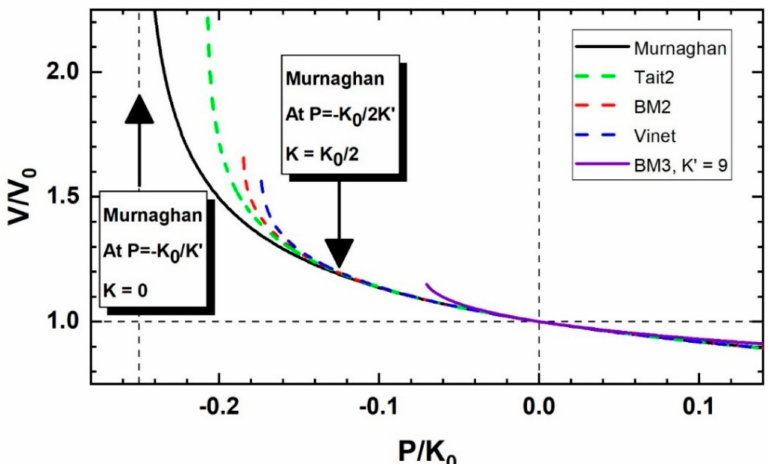
Figure 2. Volume-pressure variation for Murngahan, Vinet, 2nd-order Tait and Birch-Murnaghan isothermal EoS, with K 0 = 125 GPa and K’ 0 = 4, parameters similar to mantle composition olivines and forsterite (e.g., [7]). The 3rd-order Birch-Murnaghan EoS (deep purple line) has the same bulk modulus but K’ 0 = 9, a value typical of silicate orthopyroxenes, (e.g., [8,9]). At P ~ − K 0 / 2 K’ 0 the di ff erent EoS start to diverge, predicting significantly di ff erent volumes. When the curves of V in this graph become vertical the bulk modulus, K = − V(dP / dV) , is